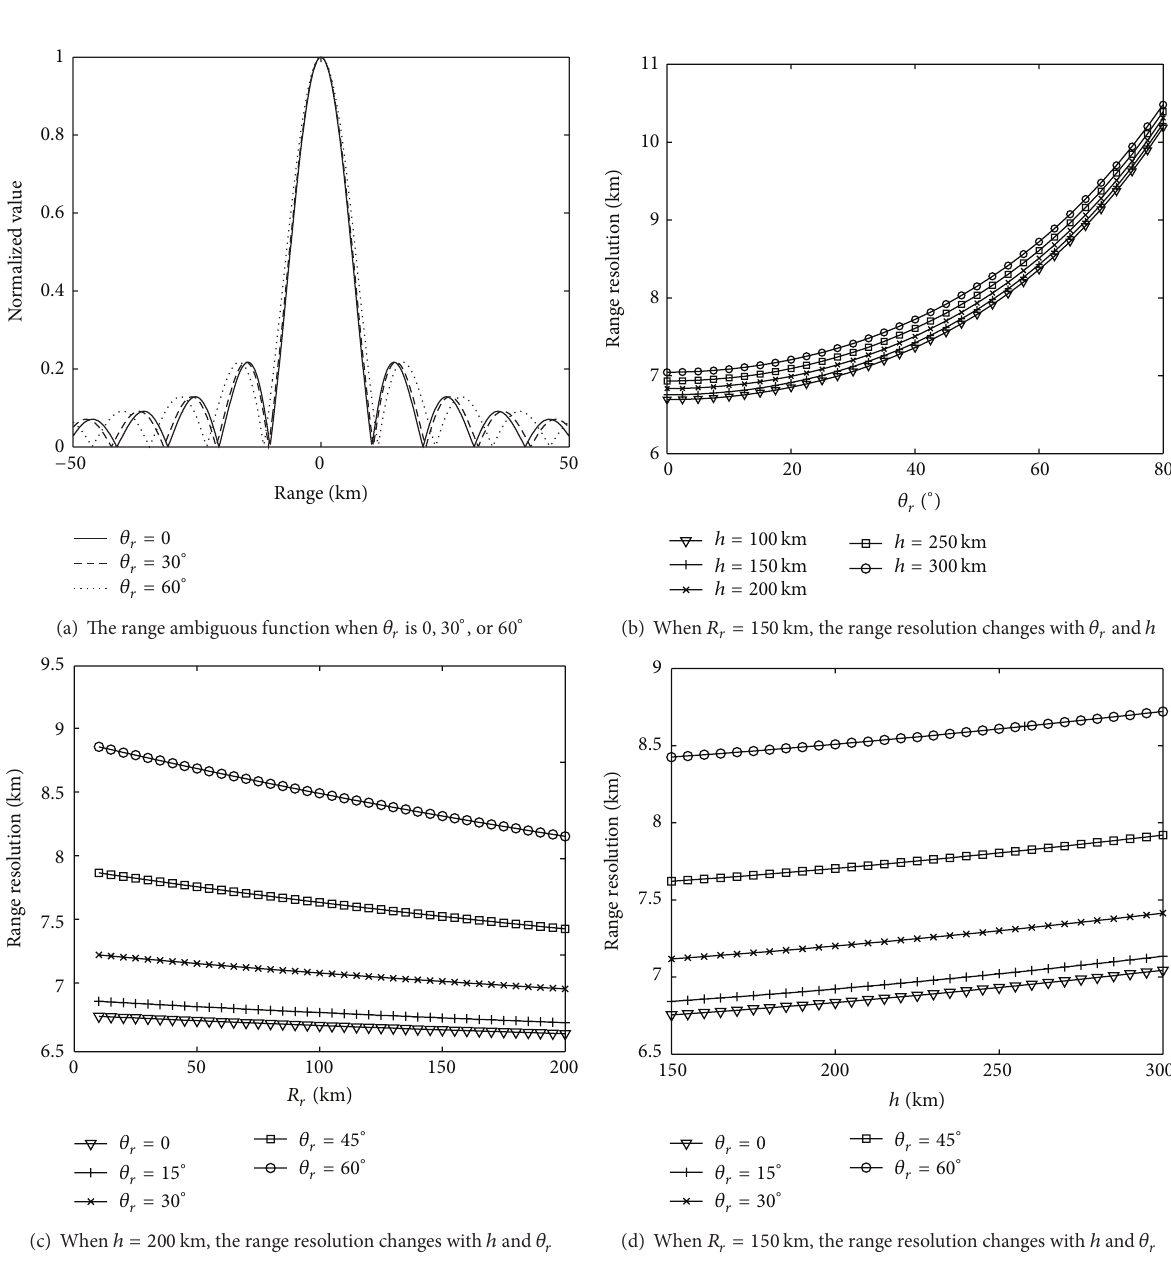
Figure 4: The ambiguous function and the range resolution of the hybrid